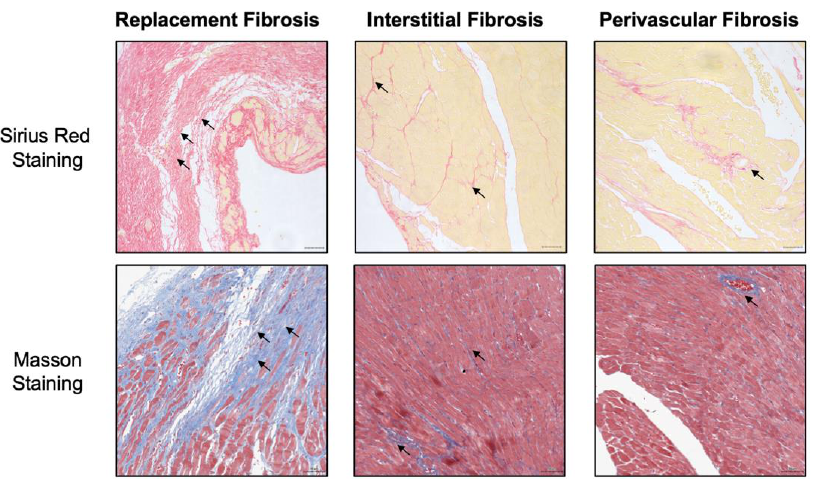
Figure 1. Three histopathological types of cardiac fibrosis via sirius red staining and masson staining. Black arrow showed increased collagen accumulation in cardiac tissue. Sirius red staining visualized collagen fibers selectively, while masson staining exhibited fibrosis blue and muscle